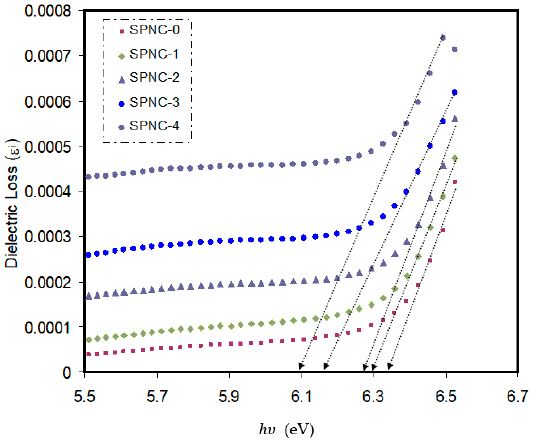
Figure 8. Variation in dielectric loss as a function of photon energy for pure and CeO 2 -doped PVA samples.